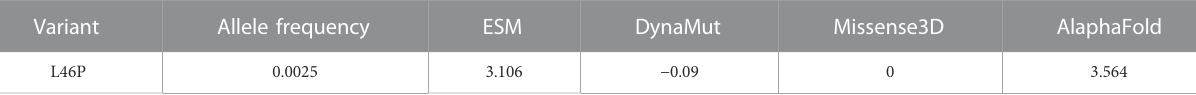
TABLE 2 Candidate variant that predicted to be benign by all